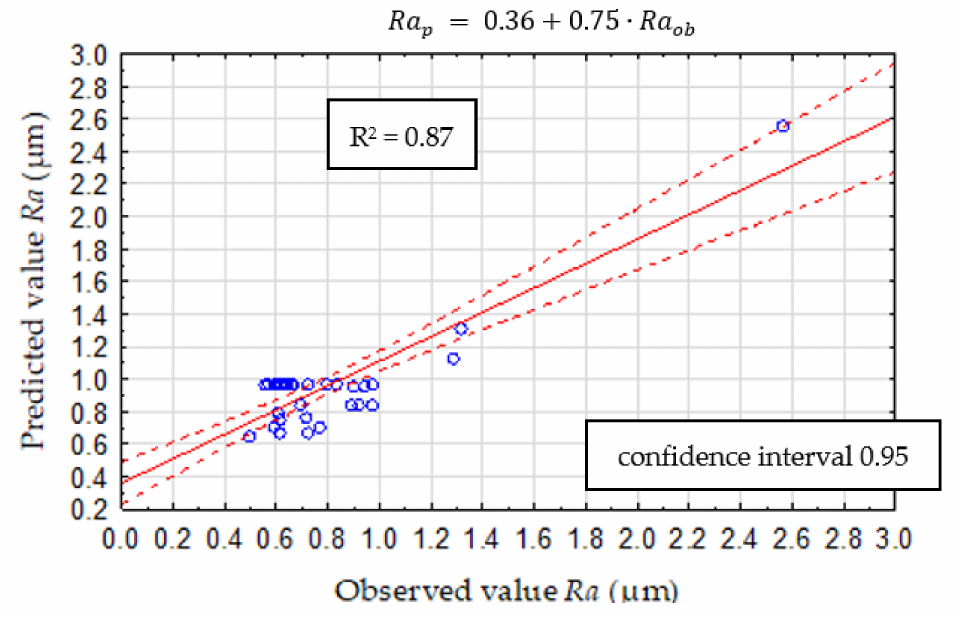
Figure 13. CHAID validation